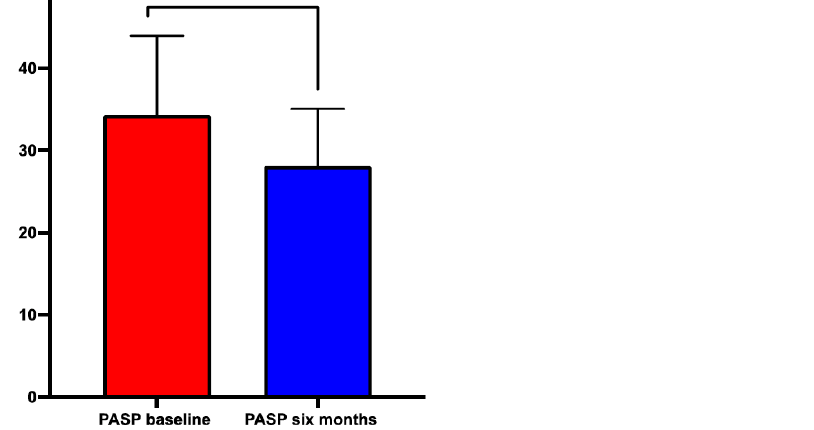
Figure 4. Effects of CCM on pulmonary artery systolic pressure.* = p < 0.05.